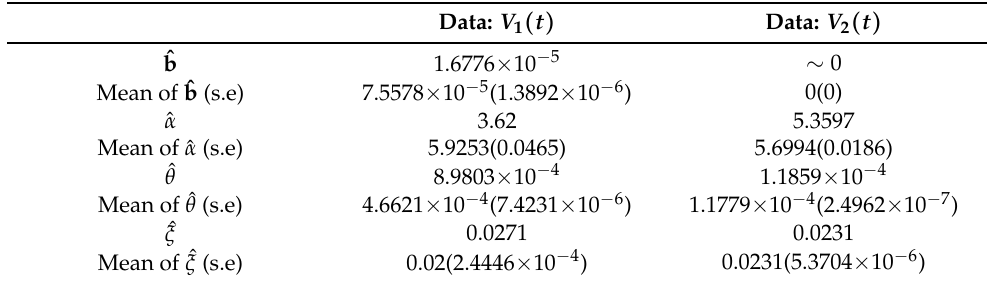
Table 3. Estimated volatility group parameters with empirical data (USO and GLD).